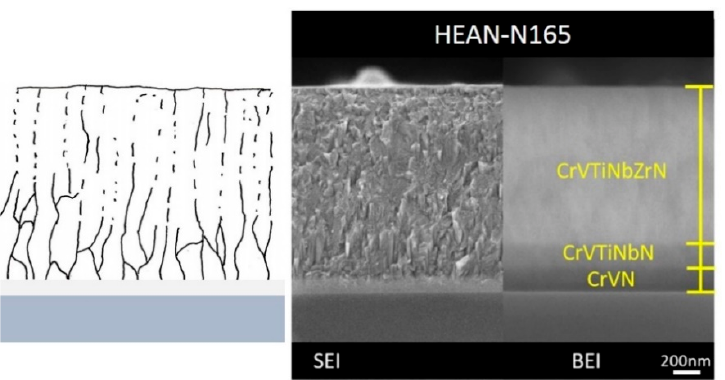
Figure 1. Cross-sectional SEM micrographs including SEI and BEI images of the CrVTiNbZr(N) coatings with different nitrogen flow rates (HEA, HEAN-N50 and HEAN-N165). A schematic illustration shows the compact columnar microstructure of the HEAN-N165 coating. Table 1. The chemical composition of the CrVTiNbZr(N) coatings with different nitrogen flow rates (HEA, HEAN-N50 and HEAN-N165). Chemical Content (at.%) Element